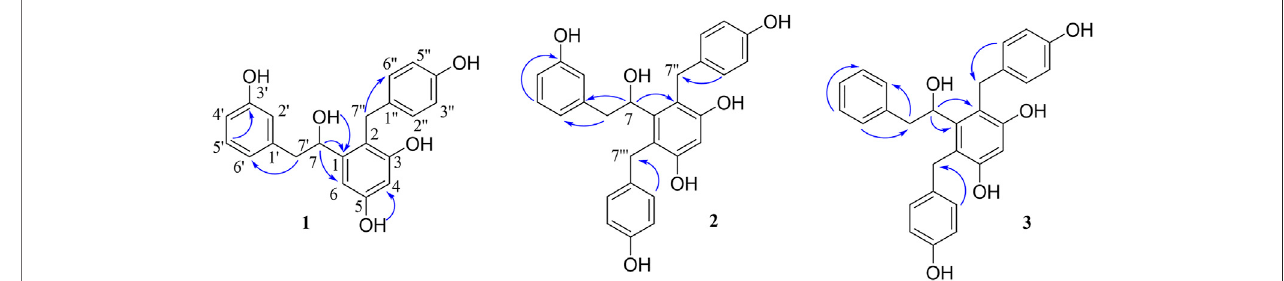
FIGURE 2 | Key HMBC correlations of compounds 1 –